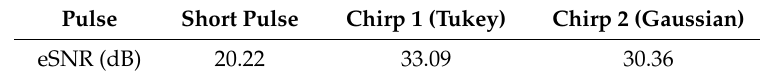
Table 5. The eSNR of three pulses.